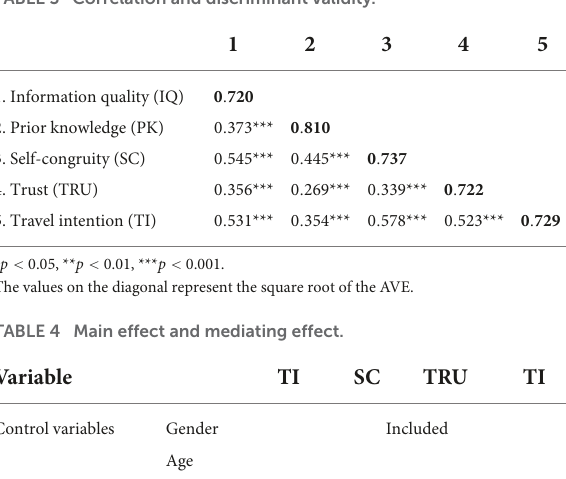
TABLE 3 Correlation and discriminant validity.